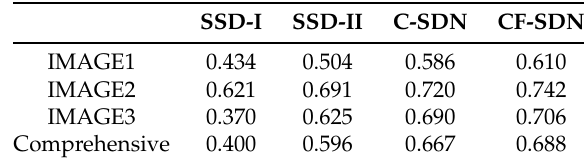
Table 5. Performance comparison of with sea-land separation on the testing set and without sea-land separation on the testing set in terms of AP.